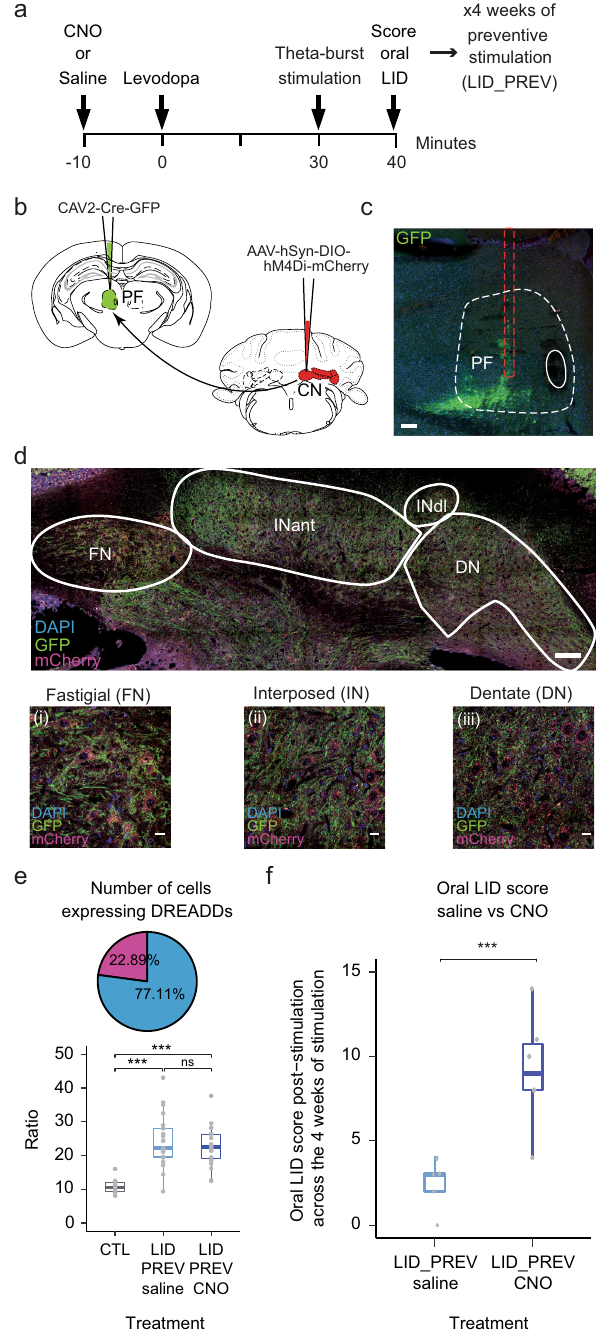
Fig. 5 CN to PF pathway inhibition counteracts the bene fi cial effects of Purkinje cell stimulation on the severity of oral dyskinesia in preventive mice. a Experimental timeline. b Schematic of mouse coronal sections showing the injection site of the retrograde CAV2-Cre-GFP in the parafascicular nucleus (PF, green) ipsilateral-to-the-lesion ( top, left ) and the injection site of the anterograde Cre-dependent pAAV-hSyn-DIO-hM4Di- mCherry in the three cerebellar nuclei (CN, red) contralateral-to-the-lesion. c Coronal section showing the injection site of retrograde CAV2-Cre-GFP in PF. Red dotted lines: needle ’ s trajectory. White dotted lines: limits of PF. Scale bar: 100 μ m. d Coronal section showing the expression of anterograde hM4Di-mCherry in neurons (red) of CN. FN: fastigial nucleus; INant: interposed nucleus, anterior part; InDL: interposed nucleus, dorsolateral hump; Lat: lateral nucleus. Blue = DAPI; green = GFP and YFP; Red = mCherry. Scale bar: 100 μ m. Insert: Postmortem histology showing hM4Di-mCherry-expressing neurons in (i) FN, (ii) IN, and (iii) DN. Scale bars: 20 µ m. e Top . Pie chart representing the proportions of neurons in CN expressing hM4Di-mCherry (in magenta) and projecting to PF compared to other types of cells (in blue). Bottom . Boxplots showing the average distribution (in %) of the neurons expressing hM4Di-mCherry over the total number of cells (Ratio) in control animals (non-virally injected animals, in gray) and preventive animals either treated with saline (light blue) or CNO (dark blue). Gray dots represent individual data points DN present in the distribution f Boxplots showing the average scored of oral LID severity at the point time corresponding to 40 min after levodopa injection, 50 min after CNO injection and after theta-burst stimulations. Averaged score comprises the 4 weeks of cerebellar stimulation in two groups: preventive animals receiving saline (LID_PREV saline, N = 5), dark blue represents preventive animals receiving CNO (LID_PREV CNO, N = 6). Boxplots represent the median score (horizontal bars), the lower and the upper quartiles. Vertical lines represent median± std. One-way Anova with two-sided Tukey HSD post-hoc test was used for 5e and non-parametric Kruskal-Wallis test with pairwise two-sided Wilcoxon test and a Benjamini & Hochberg correction were used for 5f. *** p < 0.001; ** p < 0.01; * p < 0.05; ns: p > 0.05. Source data are provided as a Source Data fi le. Schemes were taken from Franklin and Paxinos Brain Atlas, 3rd